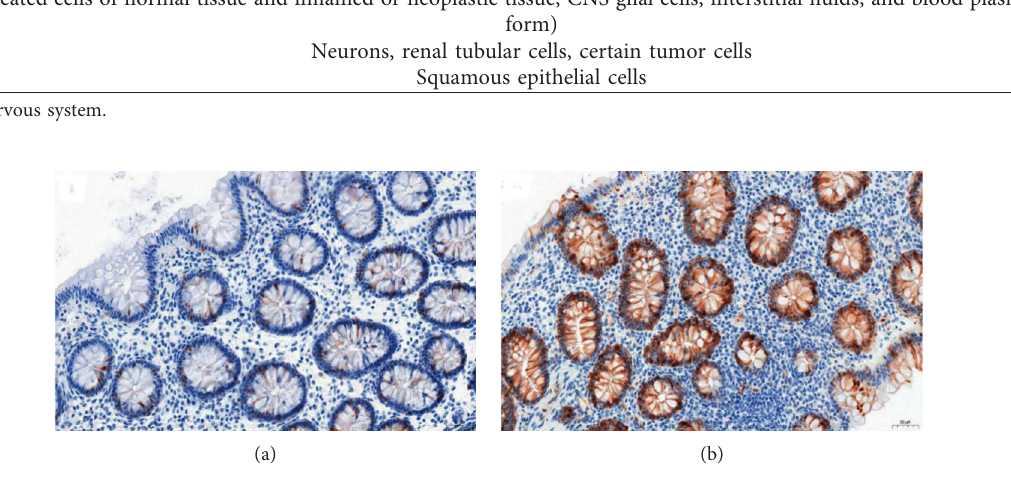
Figure 1: Analysis of immunohistochemical expression of metallothioneins I-II isoforms. (a) Low expression in colon epithelial cells and (b) high expression in colon epithelial cells and in some inflammatory cells in the tissue stroma. Magnification × 200. The immunohis- tochemical reactions were performed according to the IHC method described by Jankowska-Konsur et al. [30].